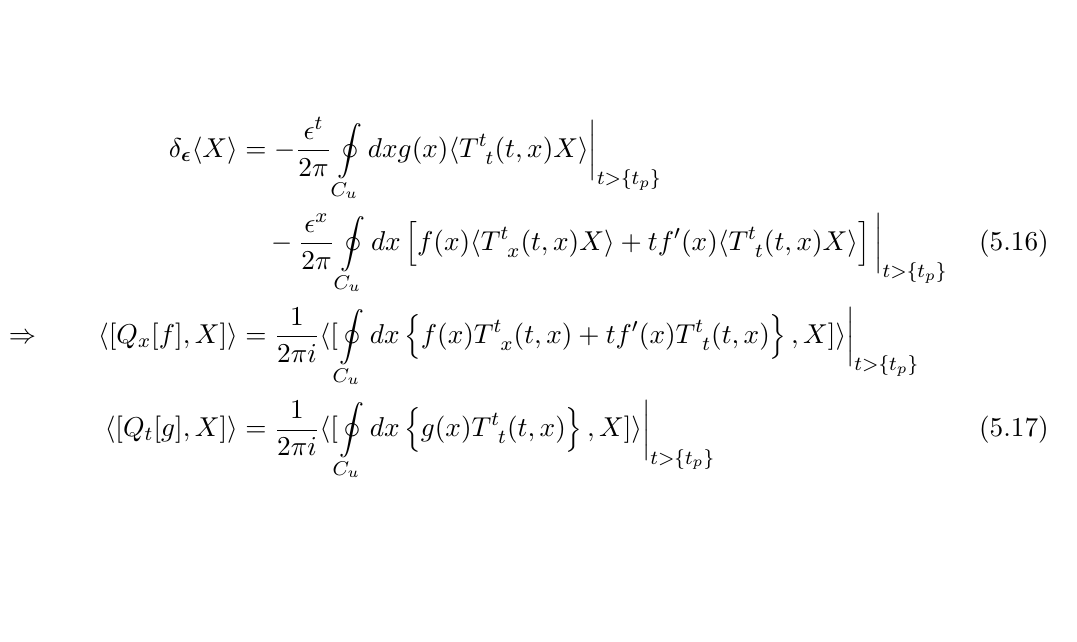
Figure 2 . ‘ i(cid:15) ’ prescription for 1 + 1 D CCFT OPEs: C u = C × where t is the ‘time of insertion’ of the conserved charge density operator; × are the singularities of the vector field. The integration over the C × principal value